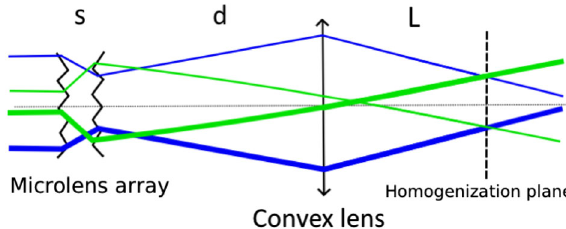
FIG. 1. Schematics of the microlens-array configuration. Initial intensity fluctuations in the beam (thin/thick ray) become evenly distributed at the homogenization